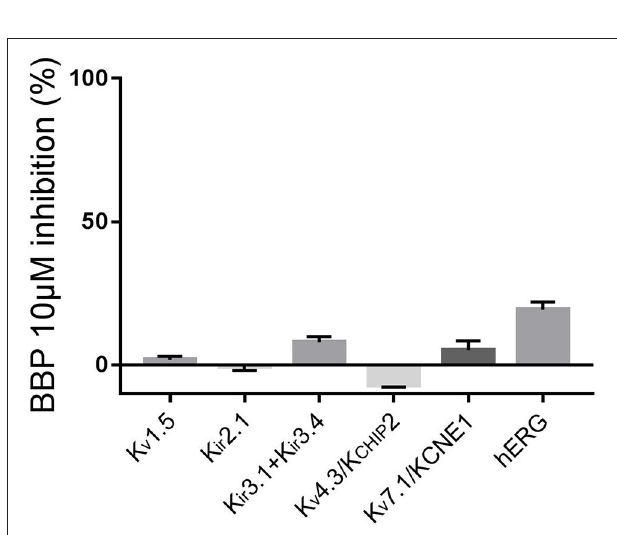
FIGURE 6 | Column graph comparing the inhibitory effect of BBP 10 µ M on a panel of voltage-gated potassium channels ( n = 5 for each current). Except hERG, none of the tested currents were significantly affected by the compound.